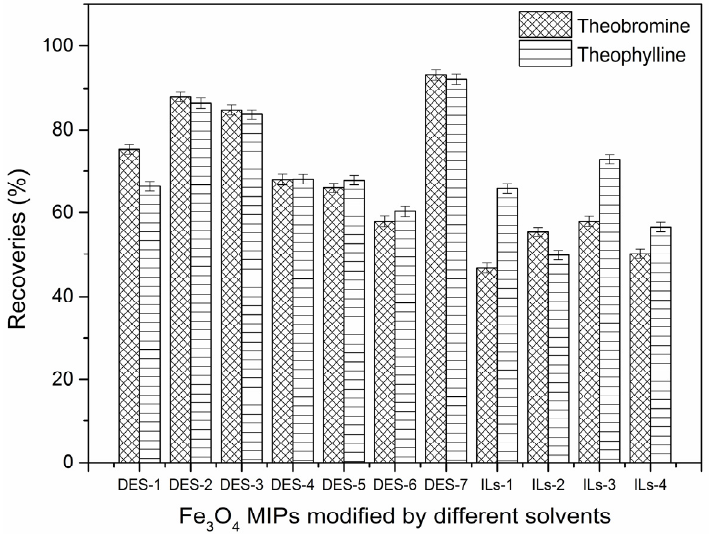
Figure 1. The recoveries of theobromine, and theophylline by different kinds of Fe 3 O 4 /MIPs.